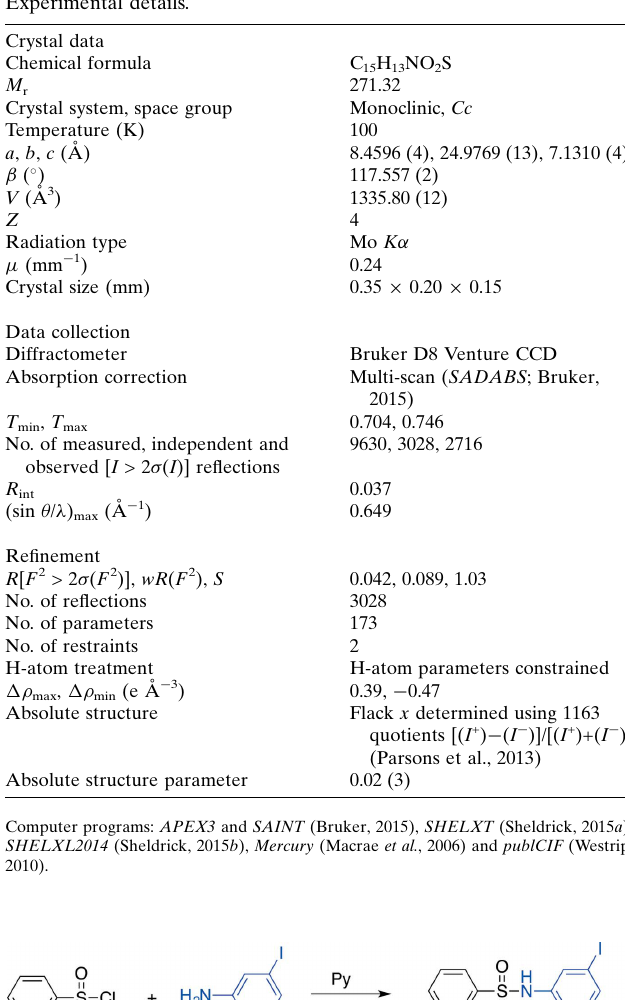
Table 2 Experimental